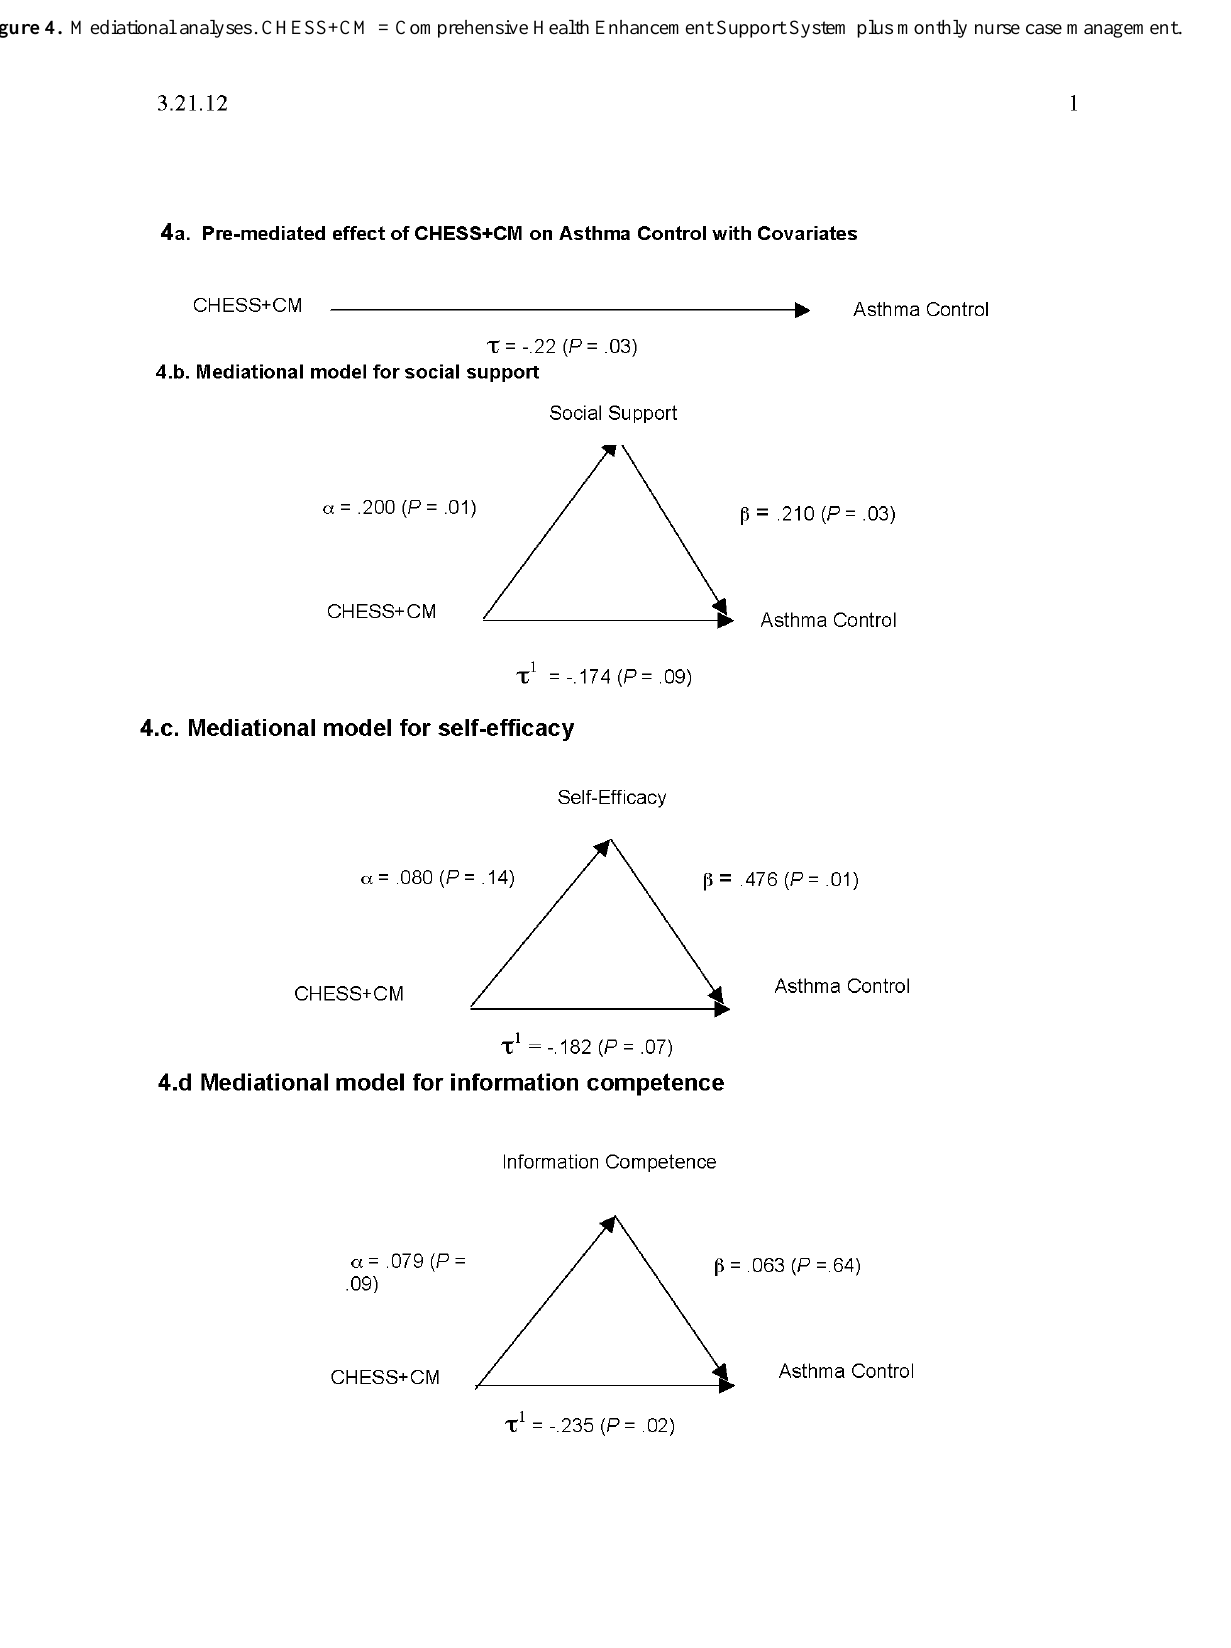
Figure 4. Mediational analyses. CHESS+CM = Comprehensive Health Enhancement Support System plus monthly nurse case